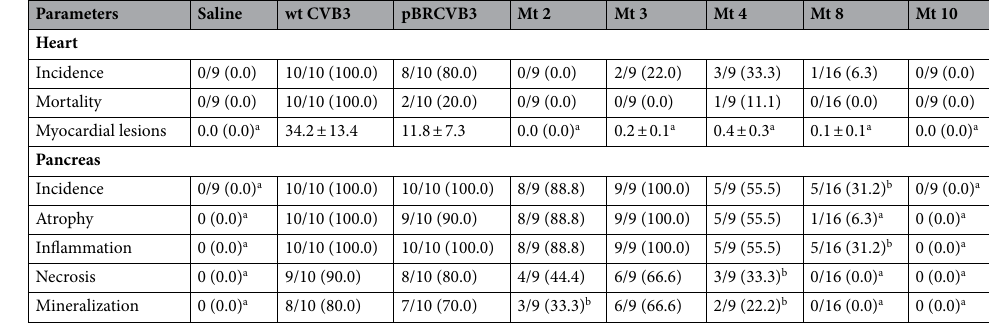
Table 1. Histological evaluation of hearts and pancreata in saline, wt CVB3, pBRCVB3, Mt 2, Mt 3, Mt 4, Mt 8, and Mt 10-infected mice. () Indicates percentages. a Denotes significant differences in comparison with wt CVB3 and pBRCVB3 group ( p < 0.001). b Denotes significant differences in comparison with wt CVB3 and pBRCVB3 group ( p <